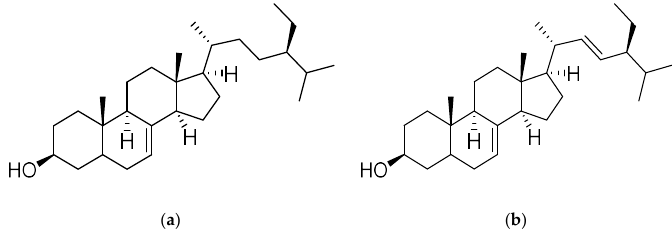
Figure 6. Chemical structures of compound; ( a ). Spinasterol; ( b ) 22, 23-dihydrospinasterol from D2 (N).